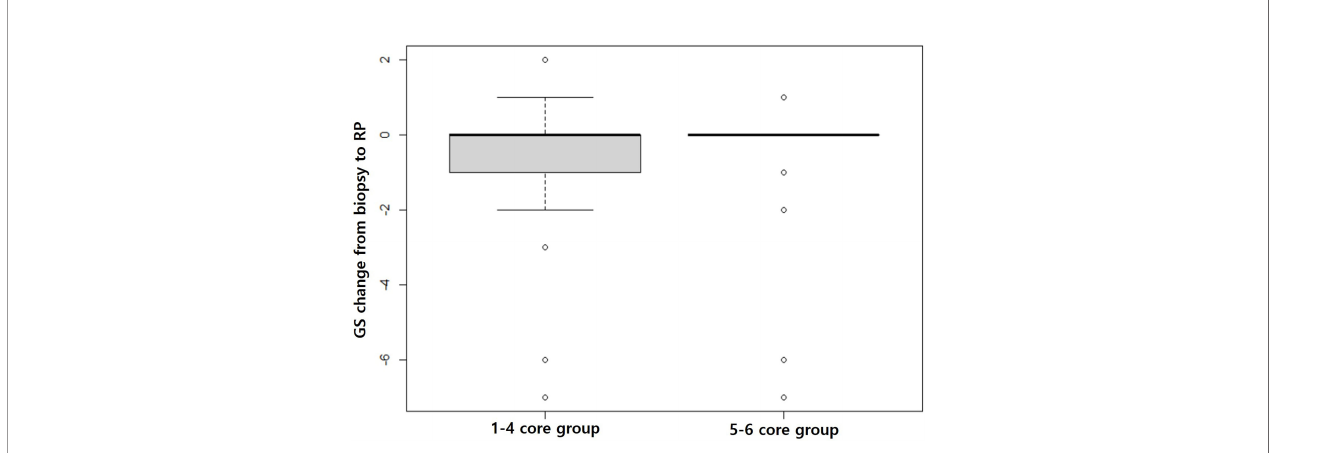
FIGURE 6 | Box plots showing GS changes from biopsy to prostatectomy. The gray box in the 1 – 4 core group is much larger than that in the 5 – 6 core group, indicating that the GS changes from biopsy to prostatectomy are signi fi cantly greater in the 1 – 4 core group than the 5 – 6 core group ( p = 0.027).